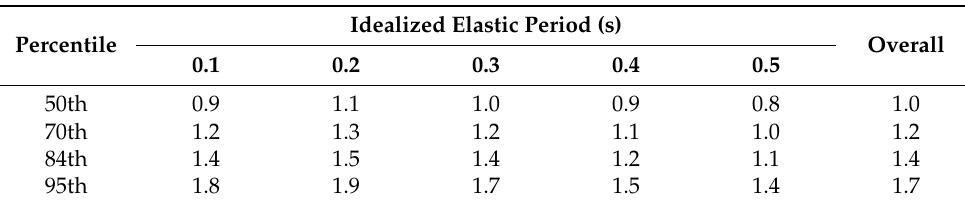
Table 4. Percentile factors of displacement demands predicted by the MN2 method for various